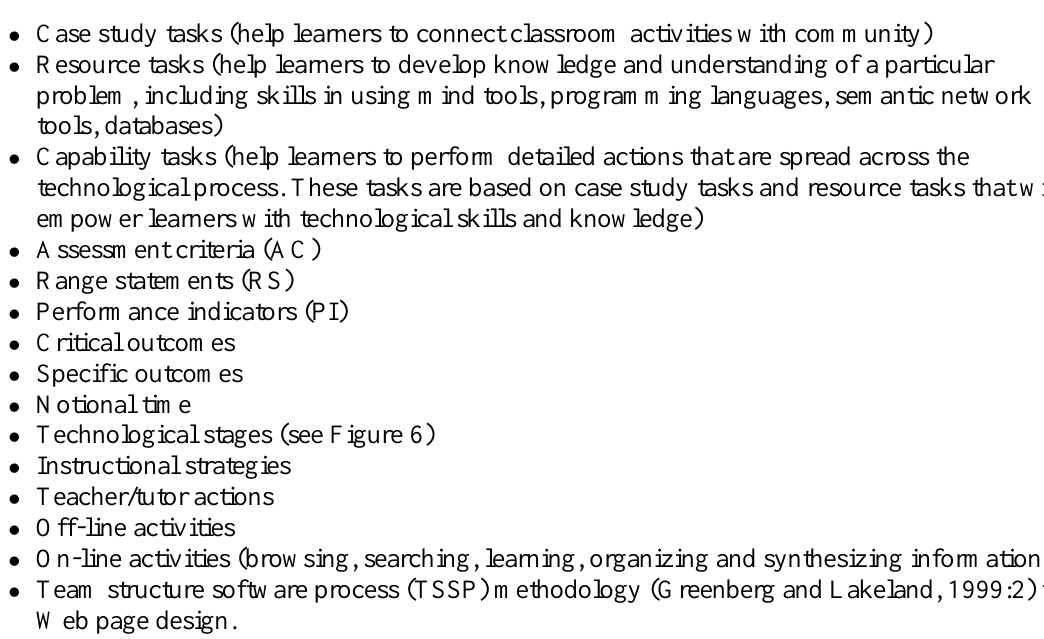
Figure 5 Critical and specific outcomes in technology